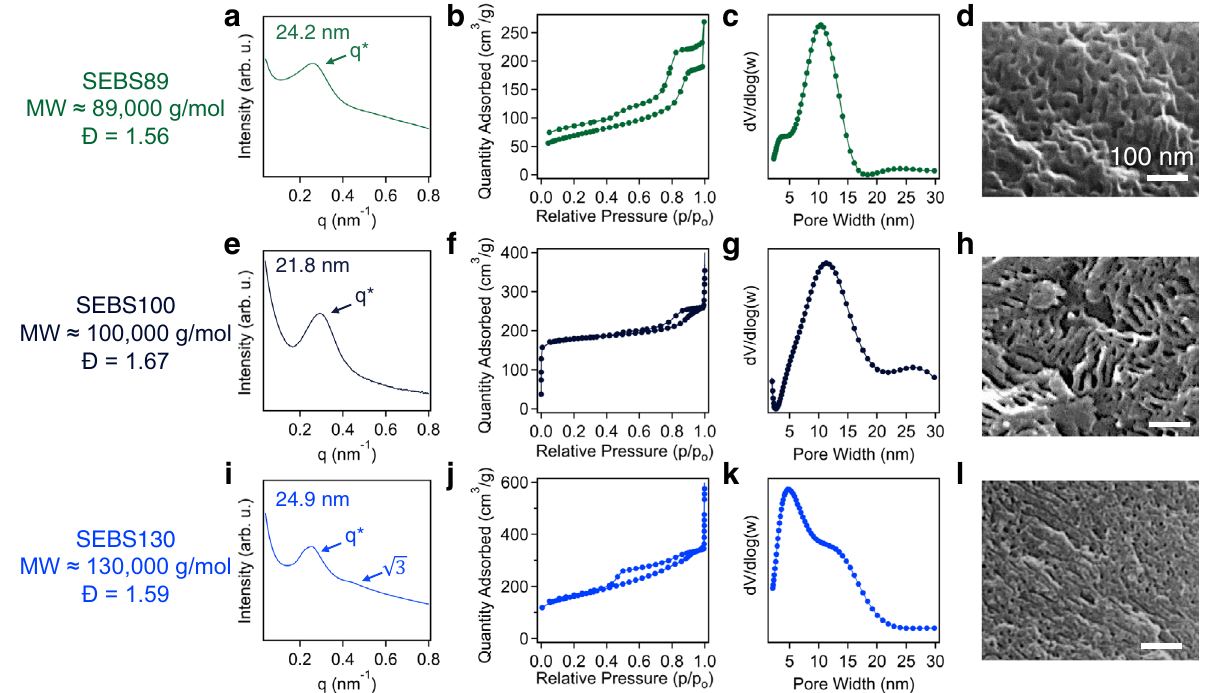
Fig. 4 | Characterization of OMCs-derived from multiple precursors. a SAXS pro fi le,( b )nitrogensorptionisotherm,( c )poresizedistributionand( d )SEMimage of OMCpyrolyzedfrom SEBS89. e SAXS pro fi le,( f ) nitrogensorptionisotherm, ( g )